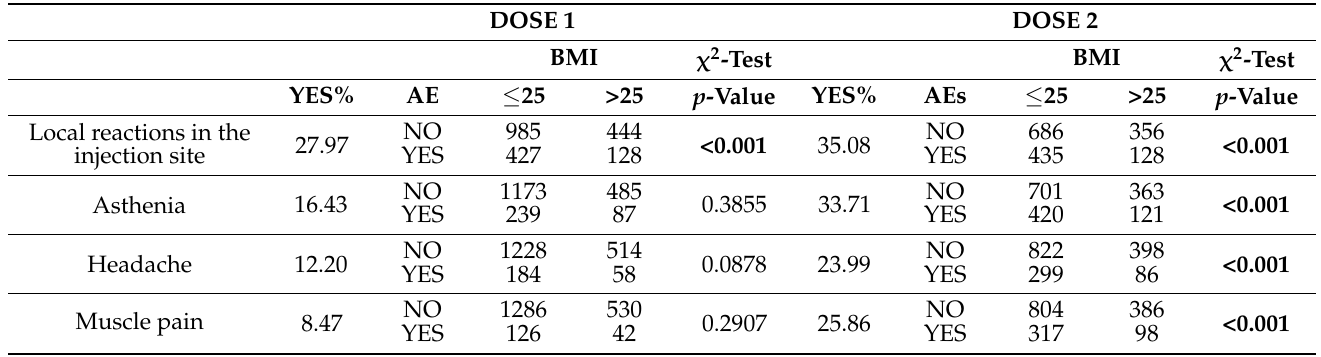
Table 1. AEs to Comirnaty vaccine reported after the first and second dose. Significant AEs are highlighted in bold. * means Severe AE, according to pharmacovigilance